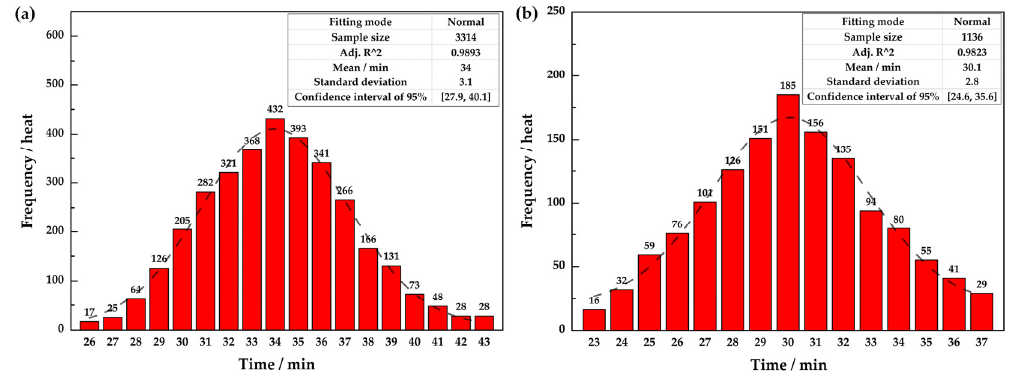
Figure 9. Distributions on processing times: ( a ) Processing times of heats in BOF before tapping; ( b ) Heating times of heats in LF.